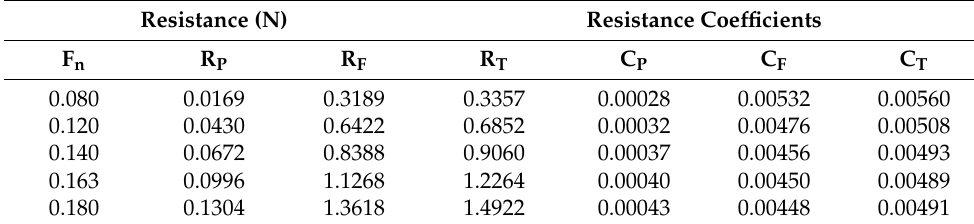
Table 5. Resistance acting on the bulbous bow model in calm water.